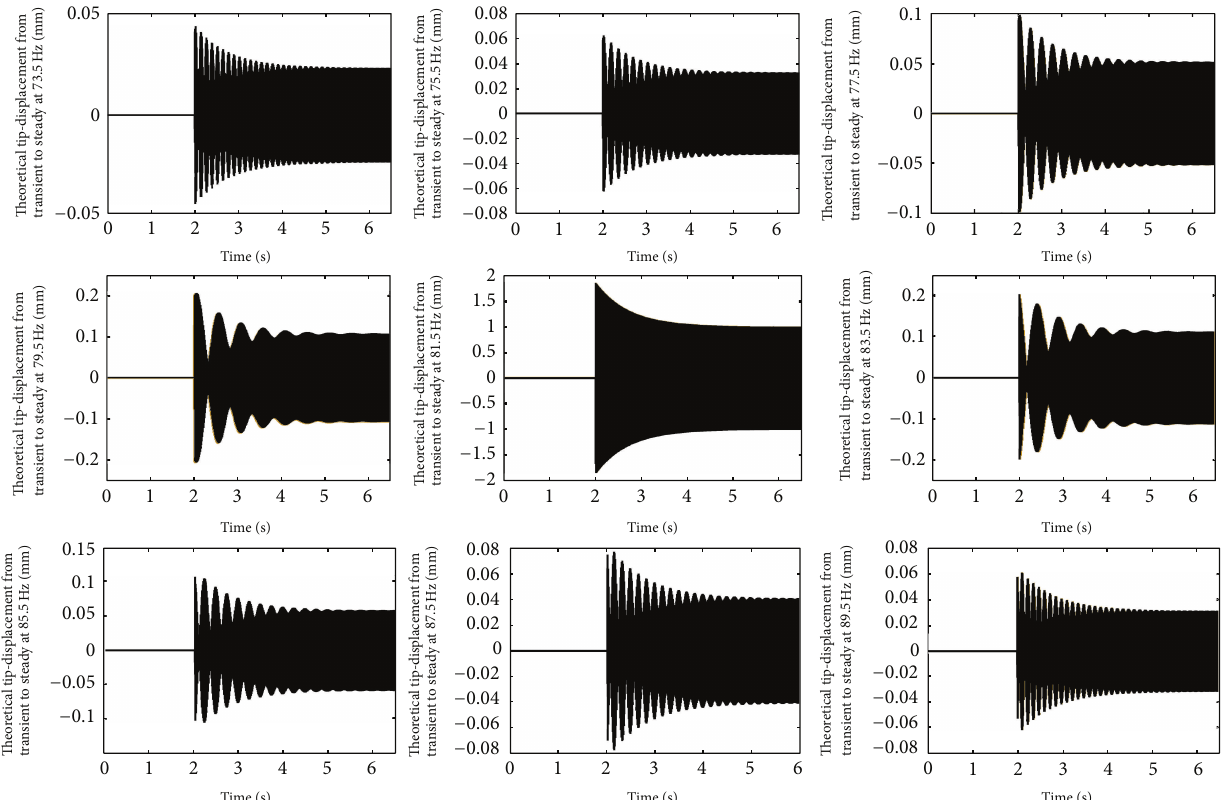
Figure 12: Theoretical tip displacement responses with third-type mode shape of the beam from transient to steady state. Table 3: The first natural frequencies and the resonant displacements at some certain positions. Resonant frequency or